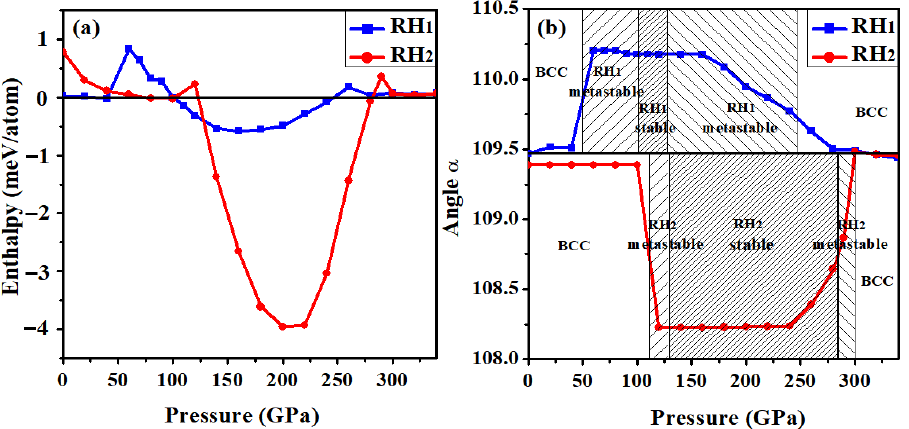
Figure 1. ( a ) Enthalpy difference of vanadium in RH1 and RH2 structures at zero Kelvin with respect to the BCC phase as a function of pressure. ( b ) Variation of angle α in RH1 and RH2 structures as a function of pressure at zero Kelvin. Note that α = 109.47° corresponds to the perfect BCC structure. (By the courtesy of Ref. [54]).